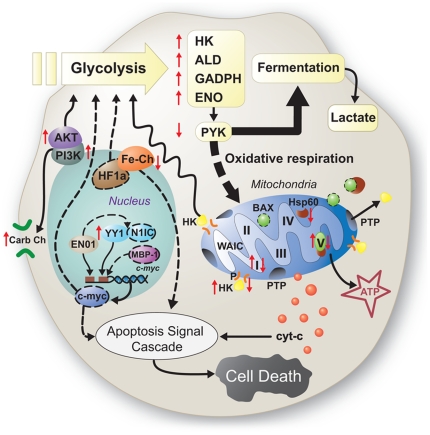
Changes in energy metabolism and apoptosis in response to METH
treatment.In METH metabolic syndrome, key glycolytic enzymes
[i.e., HK (hexokinase), ALD (aldolase), GAPDH
(glyceraldehydes 3-phosphate dehydrogenase), and ENO (enolase)] are
up-regulated (upward-pointing red arrows), presumably leading to higher
glycolytic flux. PYK (pyruvate kinase), however, was down-regulated
(downward-pointing red arrow), diverting pyruvate away from oxidative
respiration towards fermentation to lactic acid. Mitochondrial
degradation (see Figure
3 for detailed discussion) and dysregulation of the electron
transport chain (see Figure
1) may also contribute to decreased oxidative respiration.
Hsp60 binds to BAX, preventing apoptosis. Thus, the down-regulation of
Hsp60 observed with METH exposure may potentially increase free BAX,
leading to apoptosis. Multiple genes known to transcriptionally regulate
glycolysis and/or apoptosis were differentially regulated during METH
exposure, including (i) AKT and PI3K, which were up-regulated, enhancing
glycolysis and carbohydrate transport across the cellular membrane, and
(ii) iron chelators (Fe-Ch), which were down-regulated and are known to
interact with HF1a (genes not detected experimentally, indicated by
dashed lines). In addition, ENO1 and YY1, which suppress and activate,
respectively, the transcription of c-Myc, were both up-regulated,
suggesting a loss of fine control over c-Myc. c-Myc in turn regulates
the transcription of many other genes including those involved in
apoptosis and glycolysis.